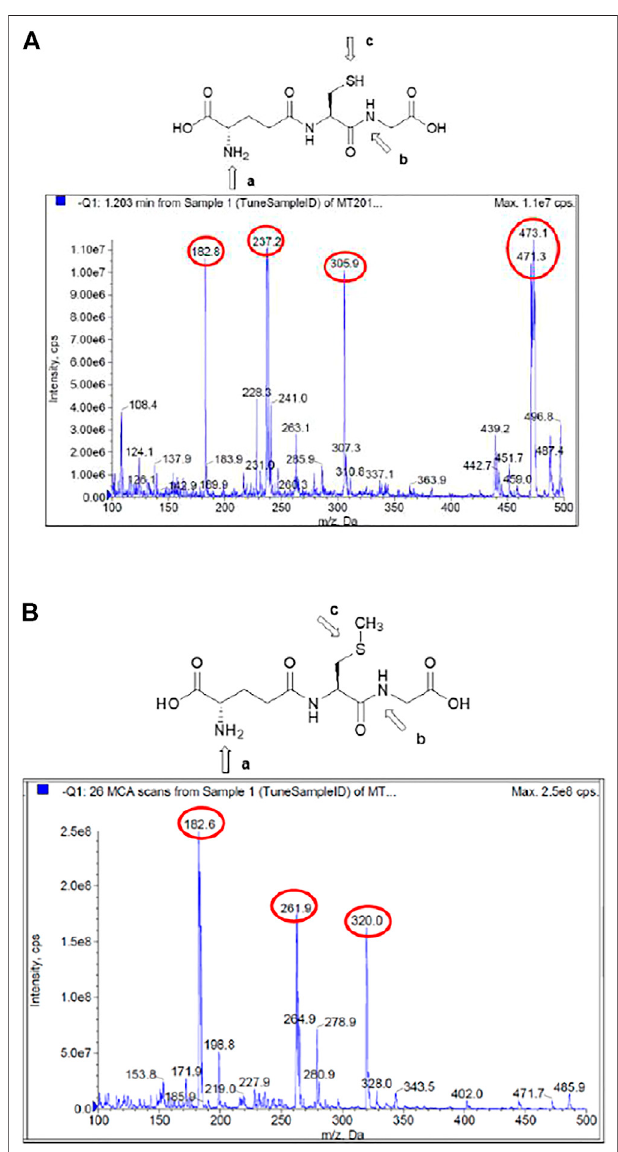
FIGURE 2 | (A) Mass/charge ratio for the reaction between GSH with ClDNB in aqueous media. (B) Mass/charge ratio for the reaction between Me – GSH with ClDNB in aqueous media.